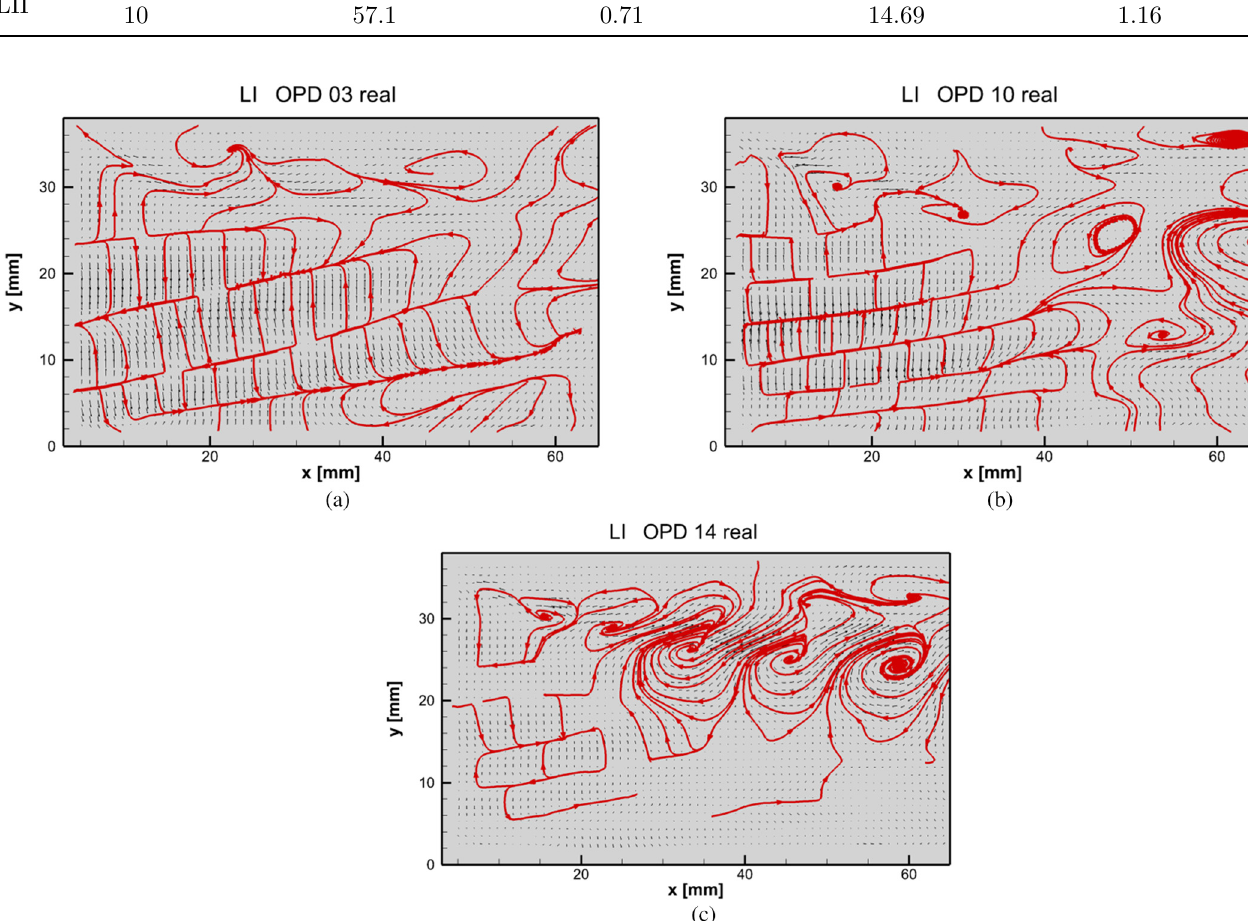
Fig. 21. Topologies of the selected OPD modes in the L branch, zone I, real parts, (a) 3, (b) 10, (c)